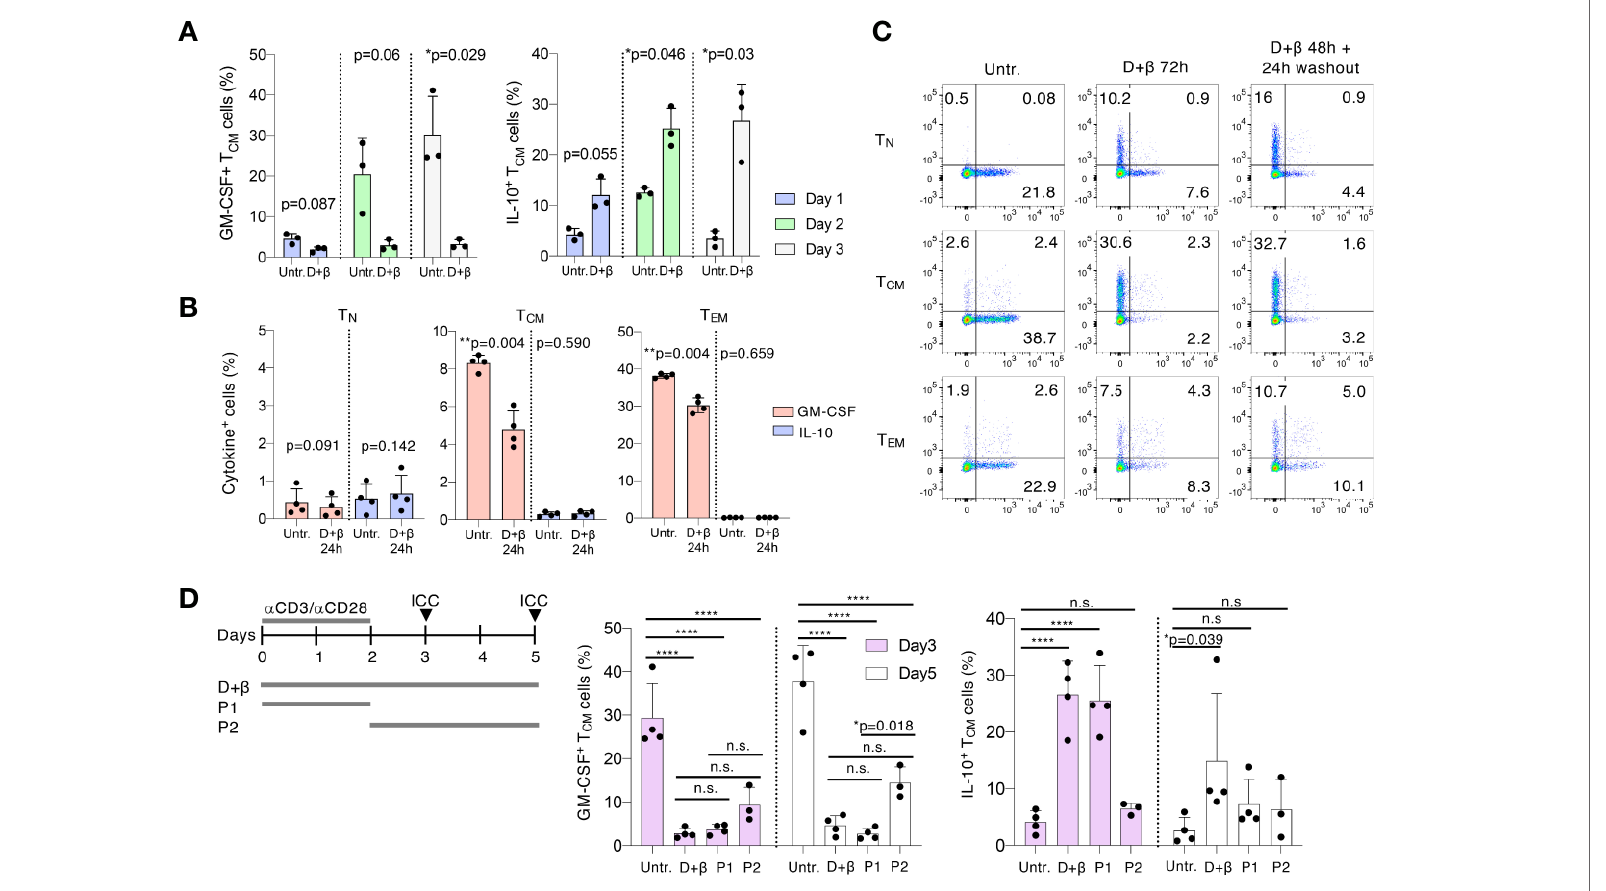
FIGURE 2 | Vitamin D and IFN- b modulate memory T cell plasticity. (A) T CM cells were freshly sorted from peripheral blood and were activated with plate-bound anti-CD3 and anti-CD28 antibodies in the presence or absence of vitamin D and IFN- b for the indicated times, followed by intracellular staining for GM-CSF and IL-10 expression. Each dot represents one donor (n=3). Mean ± SD; paired t-test, two-tailed, relative to untreated cells. (B) T cell subsets were freshly sorted from peripheral blood and were cultured for 24h with and without vitamin D and IFN- b prior to intracellular staining. Each dot represents one donor (n=4). Mean ± SD; paired t-test, two-tailed, relative to untreated cells. (C) T cell subsets were freshly sorted from peripheral blood and were activated with plate-bound anti-CD3 and anti-CD28 antibodies in the presence or absence of vitamin D and IFN- b for either three full days or for 2 days followed by a 24h washout. Expression of IL-10 and GM-CSF was measured by intracellular staining. Representative of n=4 donors. (D) Left: schematic representation of the experimental setup: T CM cells were either left untreated or were treated with vitamin D and IFN- b continuously for 3 or 5 days; or were treated for 2 days followed by washout and culture for additional 24 – 72h (P1 condition); or the treatments were added at day 2 of stimulation for additional 24 – 72h (P2 condition). Middle and right panels: results of the intracellular staining (ICC, arrows in the schematic representation) at day 3 and day 5. Each dot represents one donor (n=3 – 4). Mean ± SD; two-way ANOVA. n.s. p > 0.05; *p < 0.05; **p < 0.01; ****p <